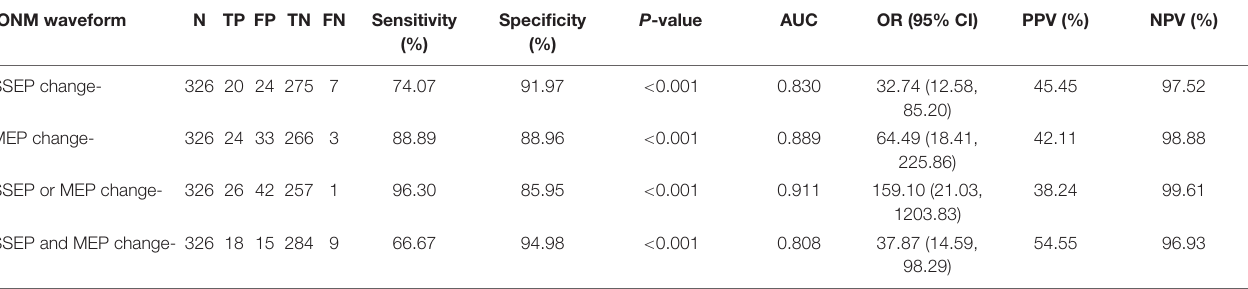
TABLE 2 | Analysis of the efficacy of single- and multimodal intraoperative neuromonitoring waveform changes. IONM